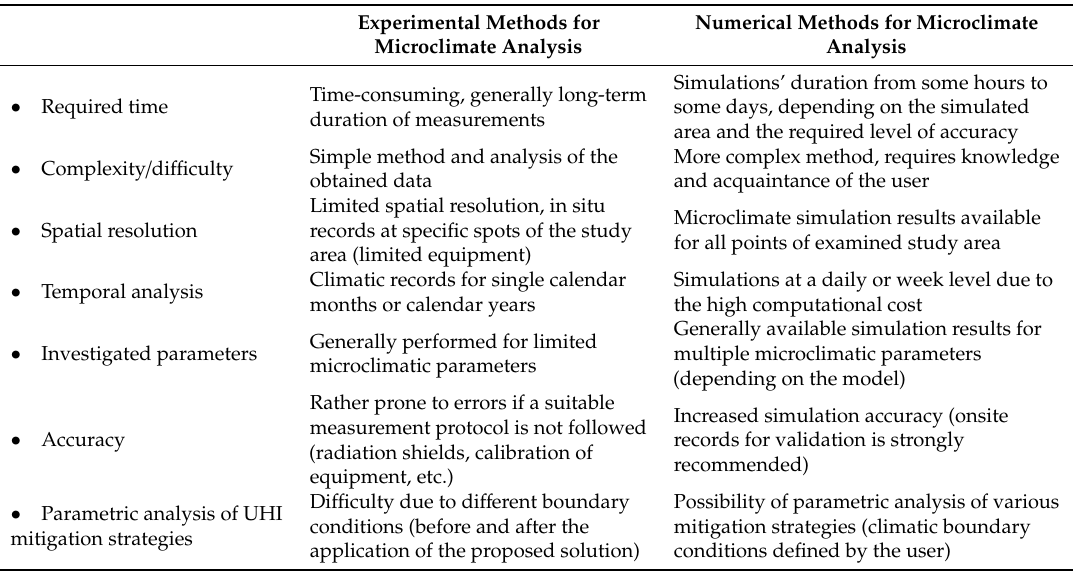
Table 6. Comparison of the basic features of experimental and numerical methods for urban microclimate analysis. Experimental Methods for Numerical Methods for Microclimate Microclimate Analysis